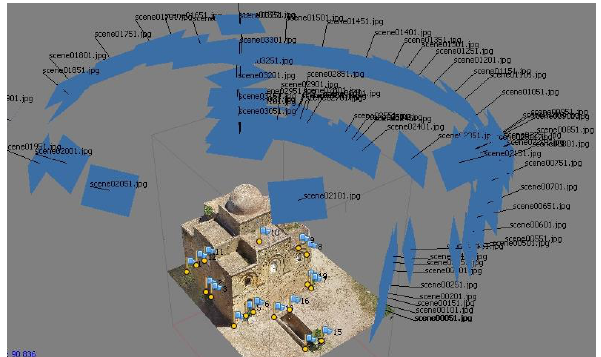
Figure 6. Photogrammetric reconstruction of the external environment using UAV camera images.